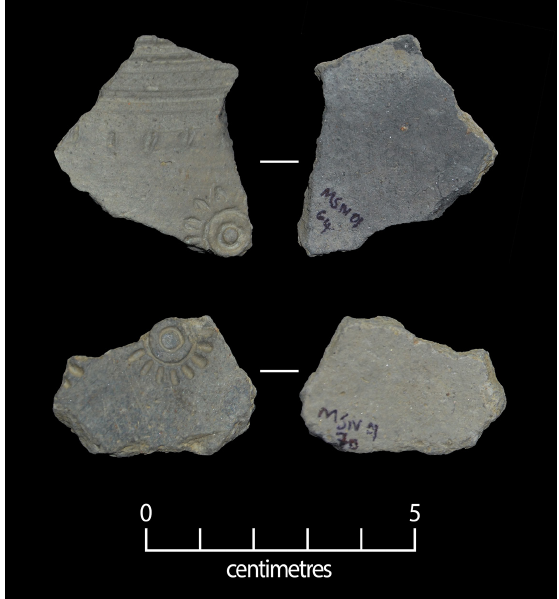
Figure 19: External surfaces of two Class 5 variant 5 potsherds, each with decoration on external